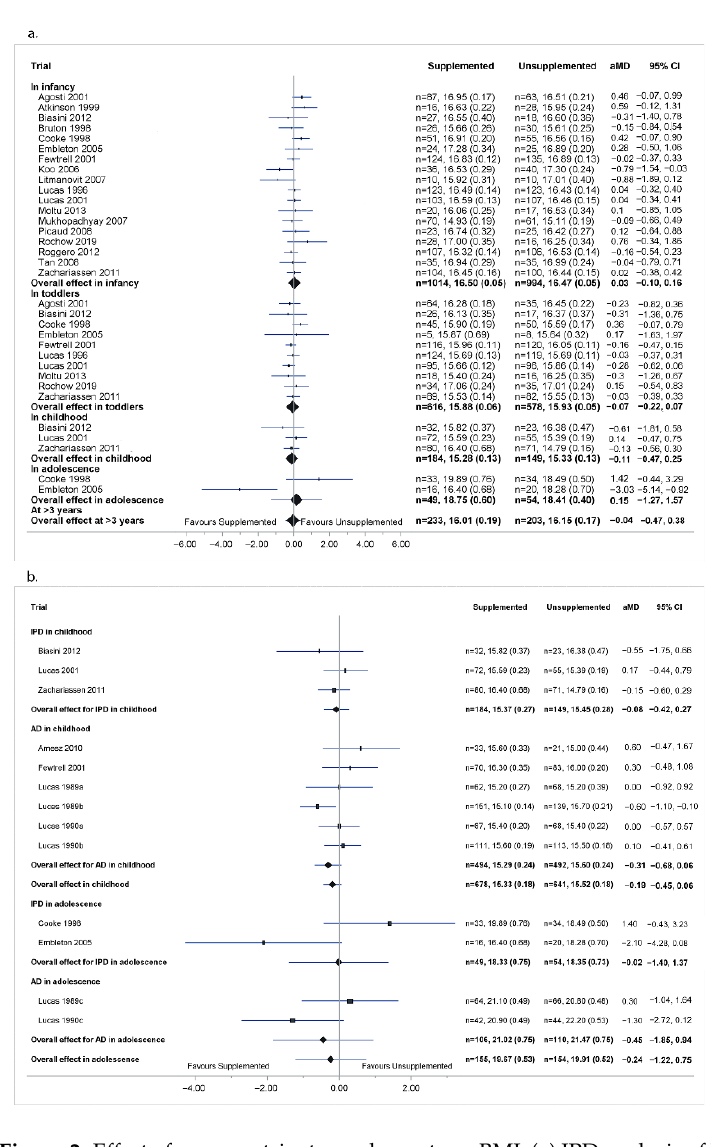
Figure 2. Effect of macronutrient supplements on BMI. ( a ) IPD analysis of BMI. ( b ) Combined IPD and AD analysis of BMI in childhood and adolescence. The box size of point estimate is proportional to inverse variance data. For IPD analysis, p -value for heterogeneity in infancy = 0.43, in toddlers = 0.78, childhood = 0.39, in adolescence = 0.01, at >3 years = 0.006. Numbers in bold are overall